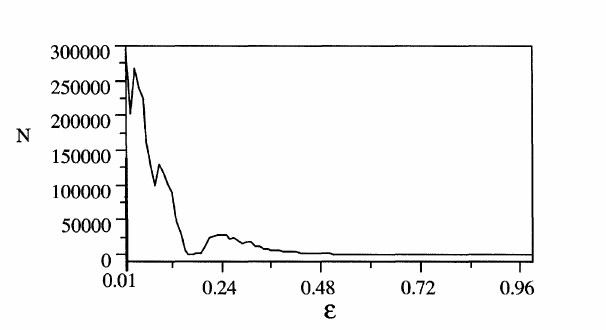
FIGURE 3 A plot of the coupling strength e versus the number of iterations N required to achieve